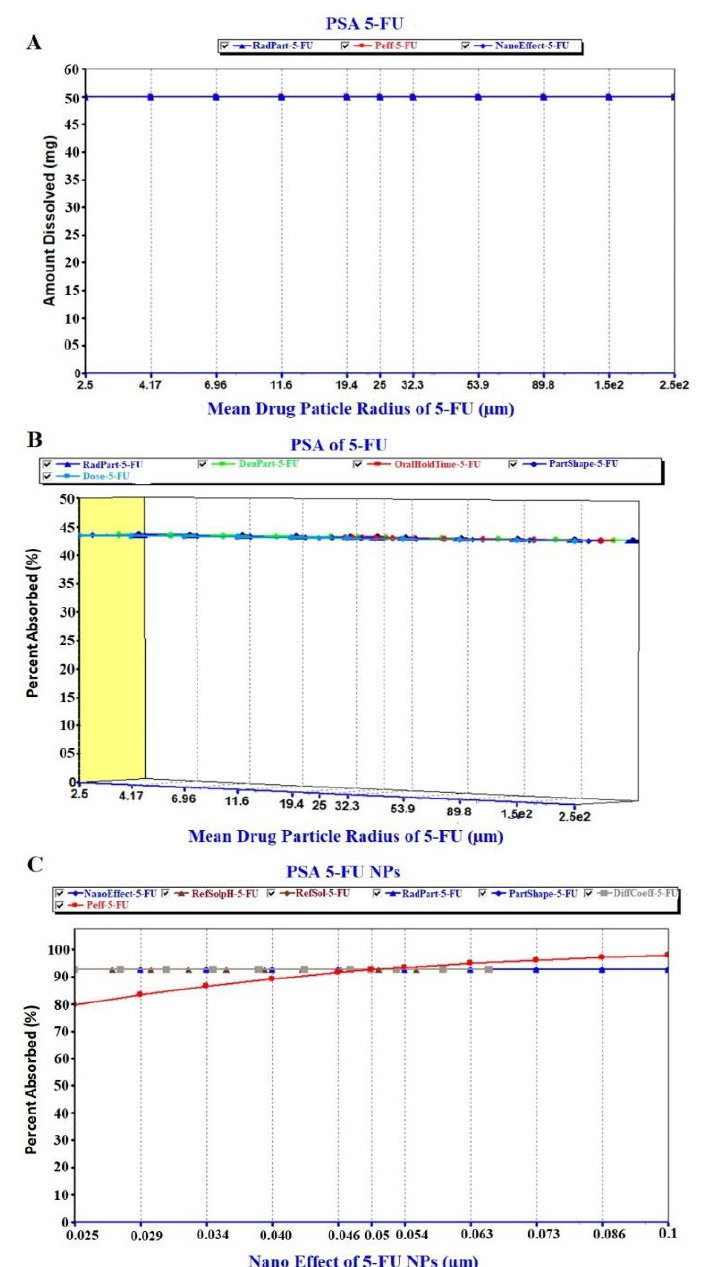
Figure 8. Parameter sensitivity assessment (PSA) of the pure 5-FU and 5-FU loaded nanoparticles: ( A ) PSA of drug dissolution, ( B ) PSA of percent drug absorbed of free 5-FU and ( C ) PSA of % absorbed of 5-FU from NPs.